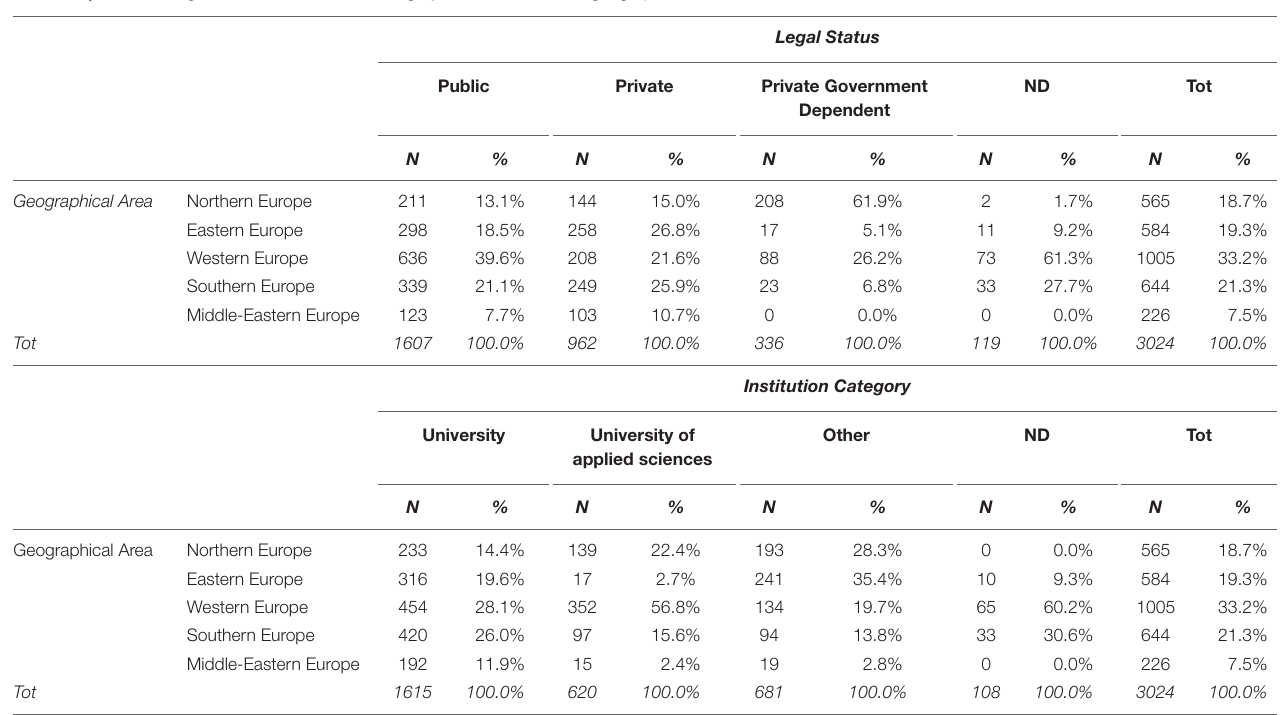
TABLE 2 | Institution legal status and institution category distribution in each geographical area.